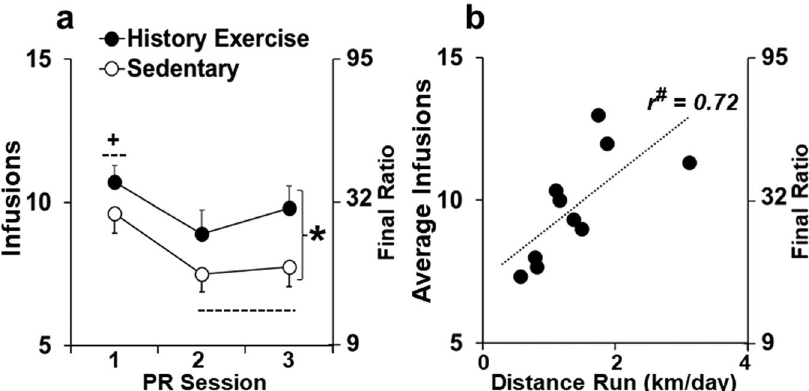
Fig. 3 Effects of discontinued high-access exercise on motivation for fentanyl. a Number of infusions (± SEM) and corresponding fi nal ratios reached under the progressive ratio (PR) schedule for each of the three stable sessions for the history of exercise and sedentary groups. b Average number of infusions (± SEM) and corresponding fi nal ratios reached under the PR schedule as a function of average distance run/ day over the 2-week high-access exercise for the history of exercise group. The Pearson correlation co-ef fi cient ( r value) for the relationship between infusions and distance run is also included. *Signi fi cant effect of group ( P < 0.05; a ); + Signi fi cant difference between sessions 1 and 2 – 3 ( P < 0.05; a ). # Signi fi cant association between infusions and distance run ( P < 0.05; b